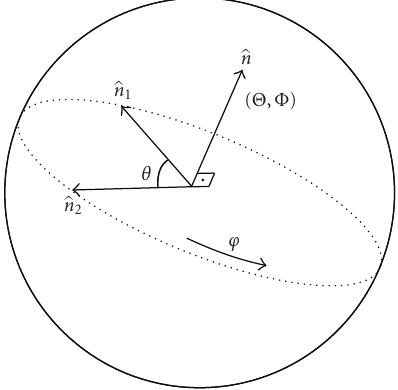
Figure 4: Geometrical representation of the 2pcf in terms of a unit disc (or